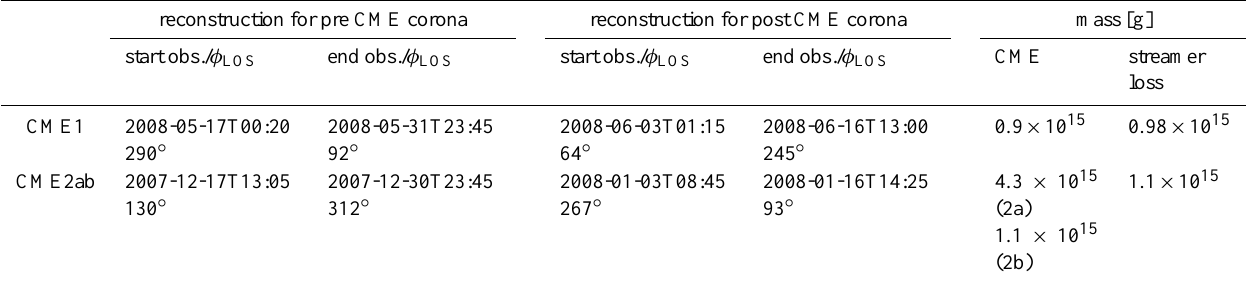
Table 1. Observation periods of input images for the tomographic reconstructions, and masses of the CMEs and streamer belt losses in the CME impacted regions (areas bounded by white square and round lines in Figs. 1, 3, 5, 7; also see Sect. 3 of the text). reconstruction for pre CME corona reconstruction for post CME corona mass [g] start obs./ φ LOS end obs./ φ LOS start obs./ φ LOS end obs./ φ LOS